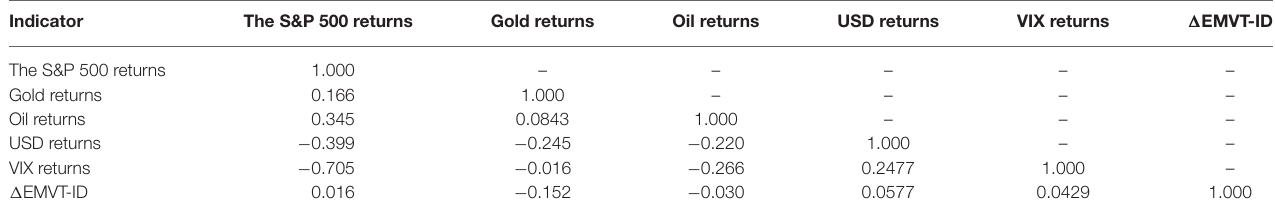
TABLE 2 | Correlation matrix (December 31, 2019–February 19,